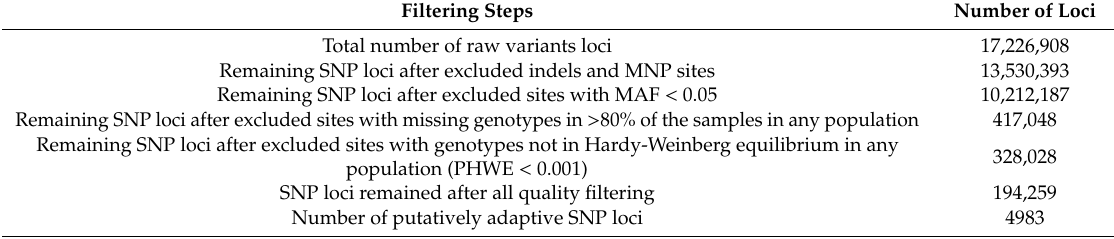
Table 3. Number of single nucleotide polymorphism (SNP) loci remained after each quality filtering steps for dataset using all sampling groups.